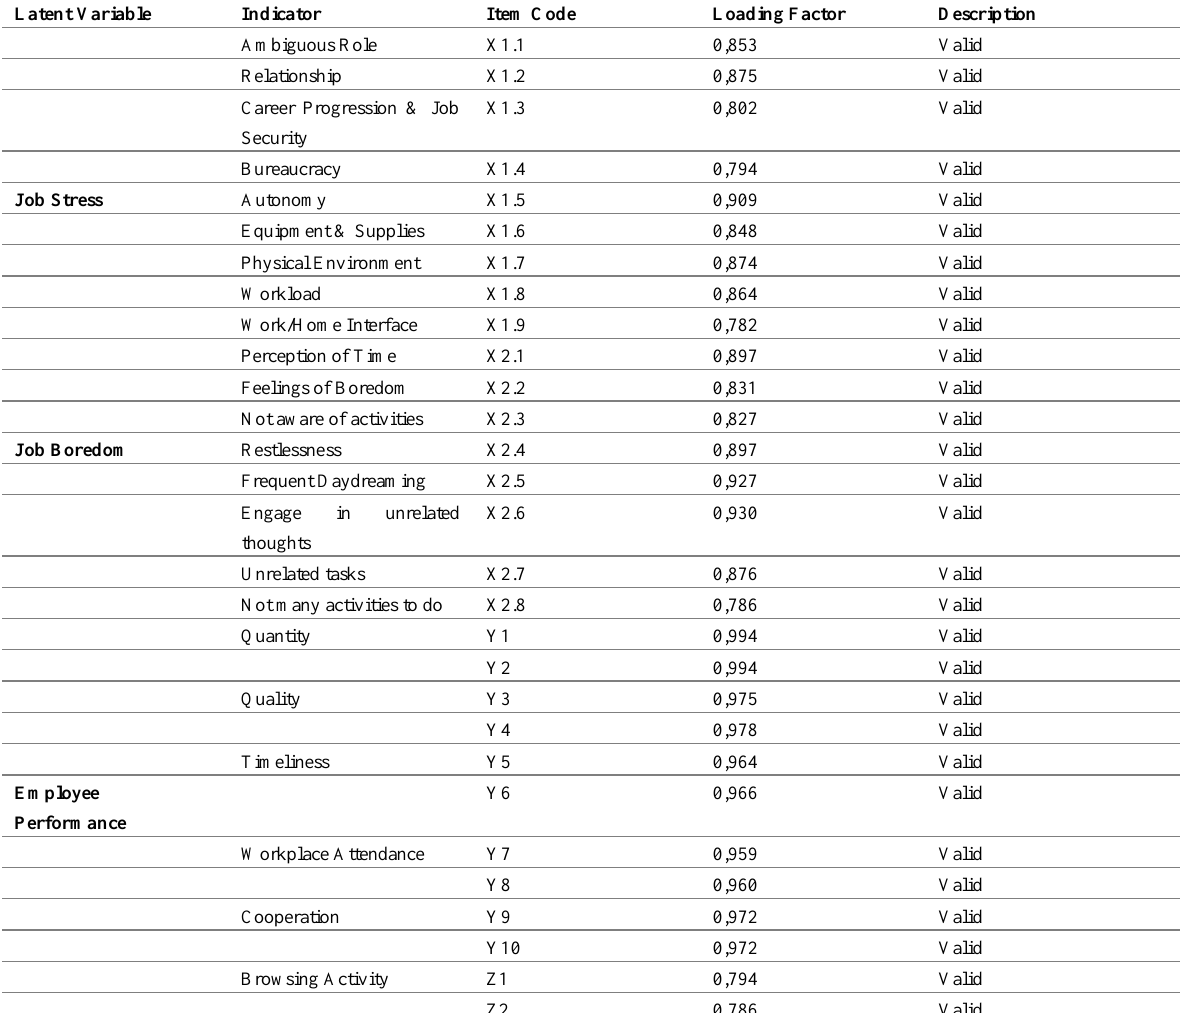
Table 2: Loading Factor